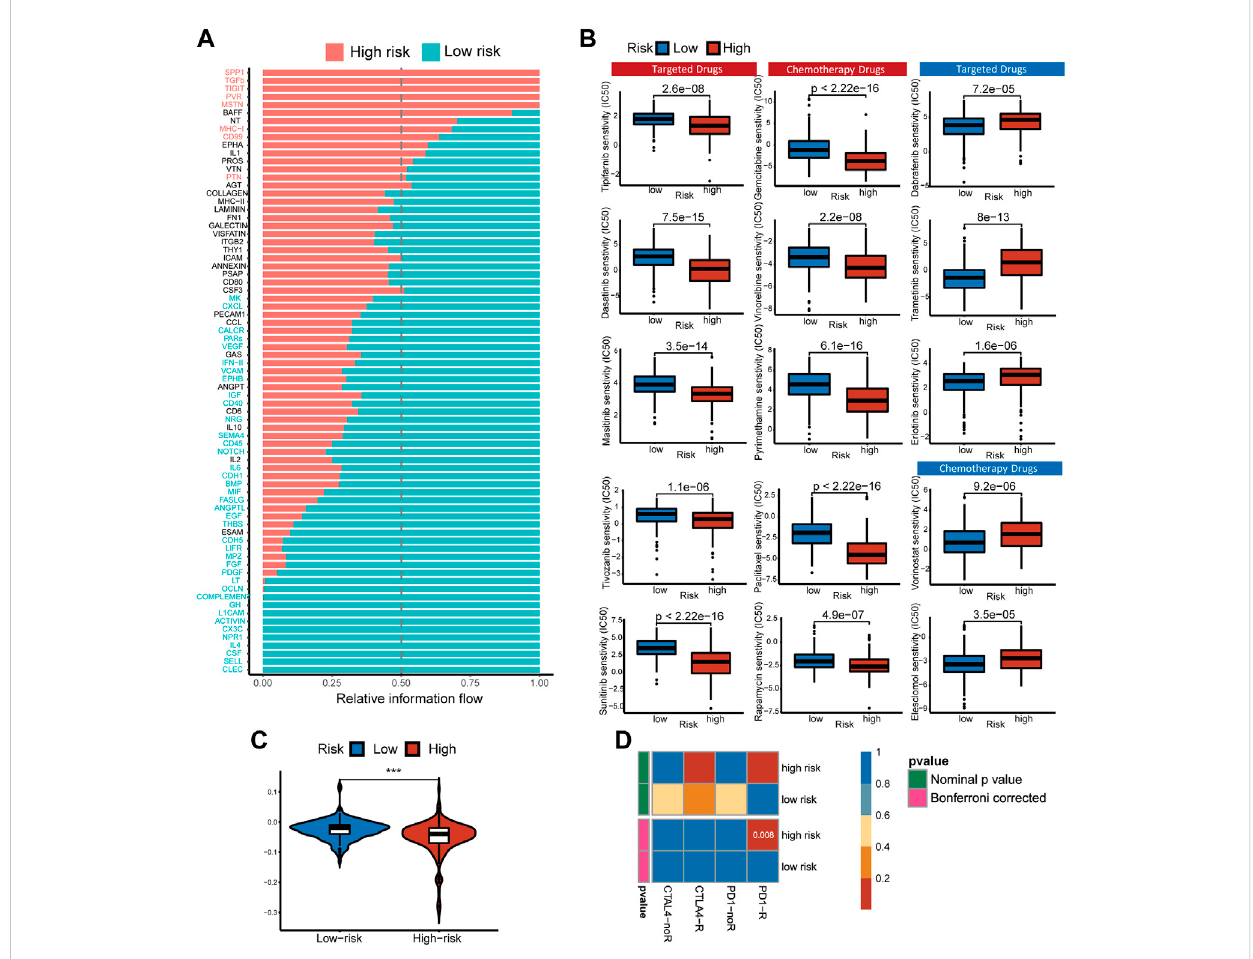
FIGURE 8 Pathways with different overall information between high- and low-risk single-cell sequencing samples. Predicting treatment response. (A) Signalingpathwayswithsigni fi cantdifferencesintheoverallintercellularinformationbetweensingle-cellRNA-Seqsamplesathigh-andlow-risk. (B) The IC50s of chemotherapeutic agents and targeted drugs related to the 5-gene signature. (C) The prediction results show the distribution of immune response scores in the high- or low-risk groups of the TCGA cohort. (D) Differences in sensitivity of subgroups based on risk score